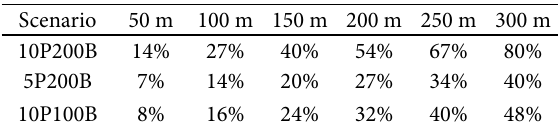
Table 3. Channel load in the scenarios for different transmission ranges